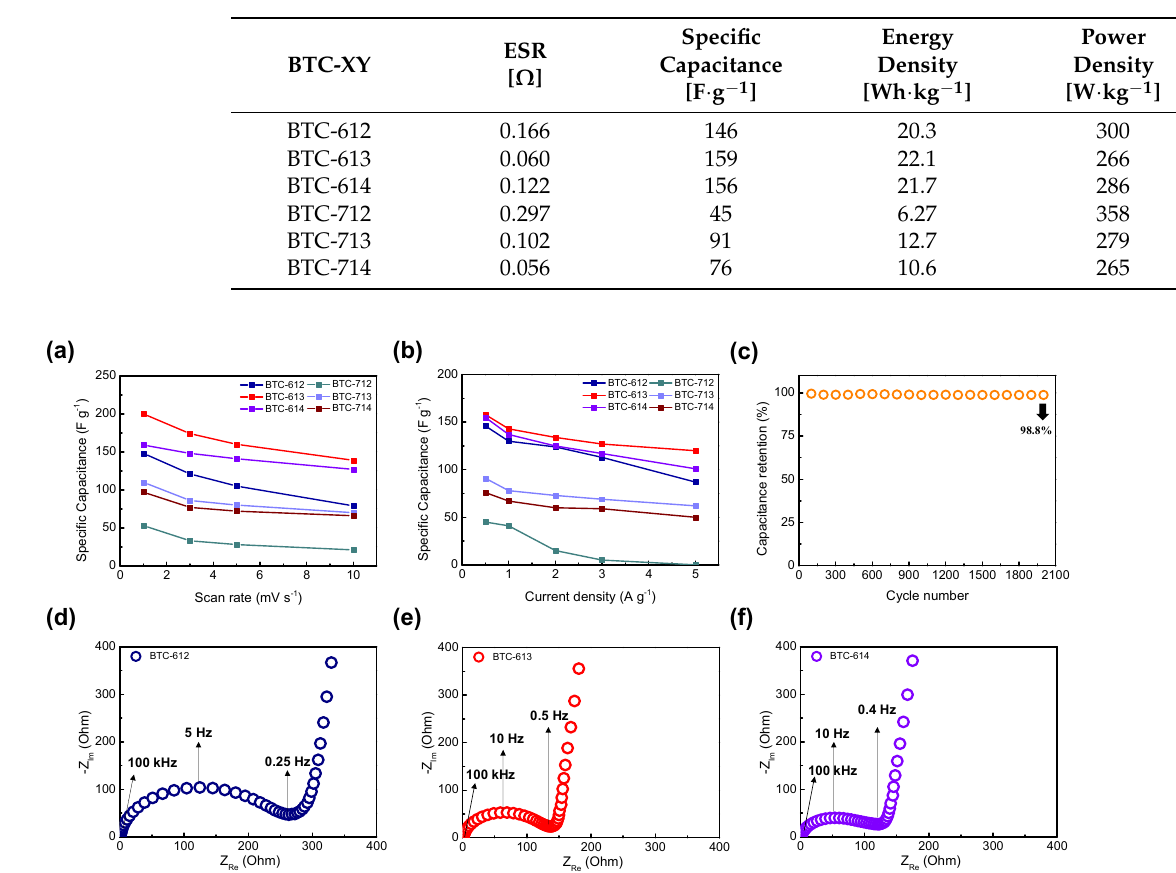
Figure 8. The galvanostatic charge–discharge curves for ( a ) BTC-612, ( b ) BTC-613, ( c ) BTC-614, ( d ) BTC-712, ( e ) BTC-713, and ( f ) BTC-714. Table 2. Electrochemical performance results of various BTC at a current density of 0.5 A∙g −1 .